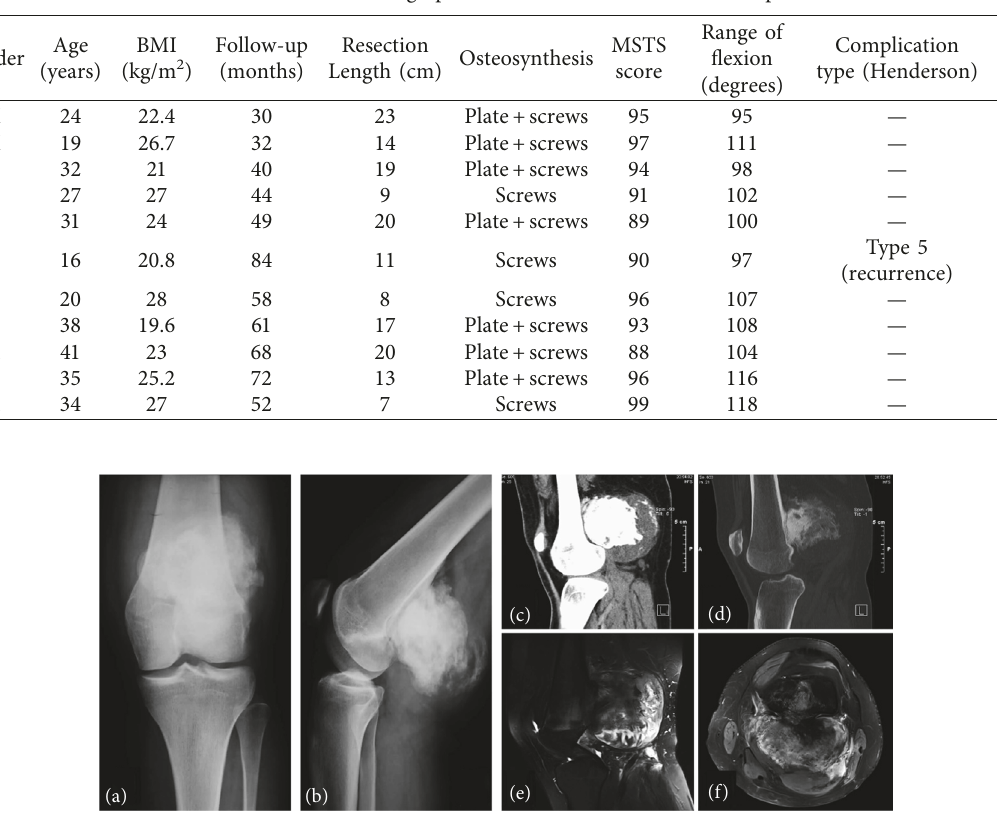
Table 1: Clinical and demographic characteristics of the included patients.